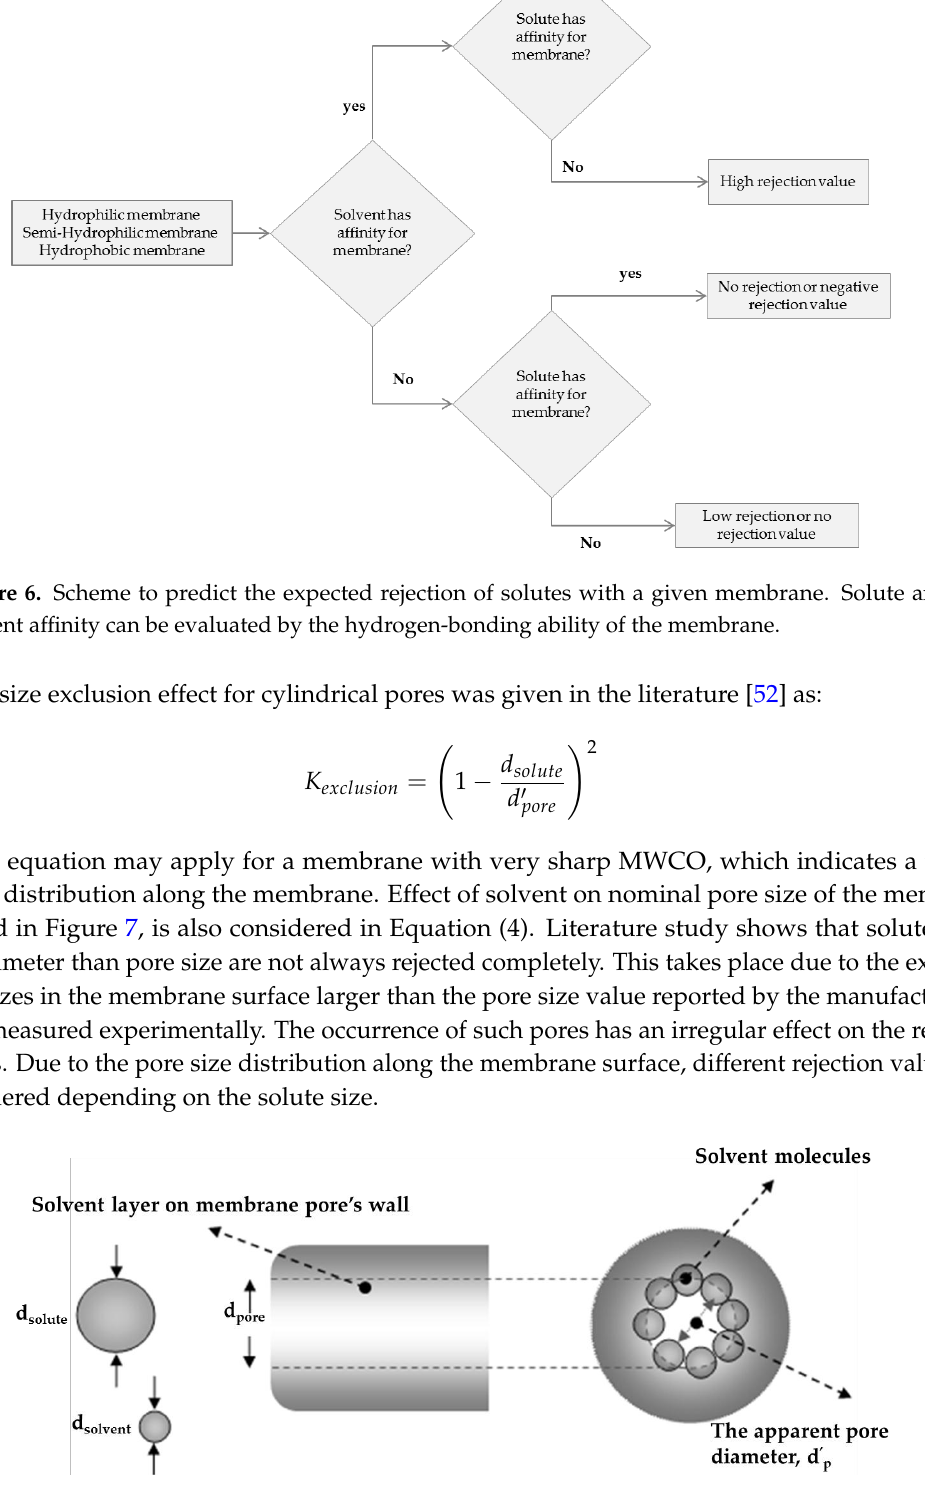
Figure 7. Schematic representation of SRNF membrane pores. The real pore size is smaller in contact with solvent.